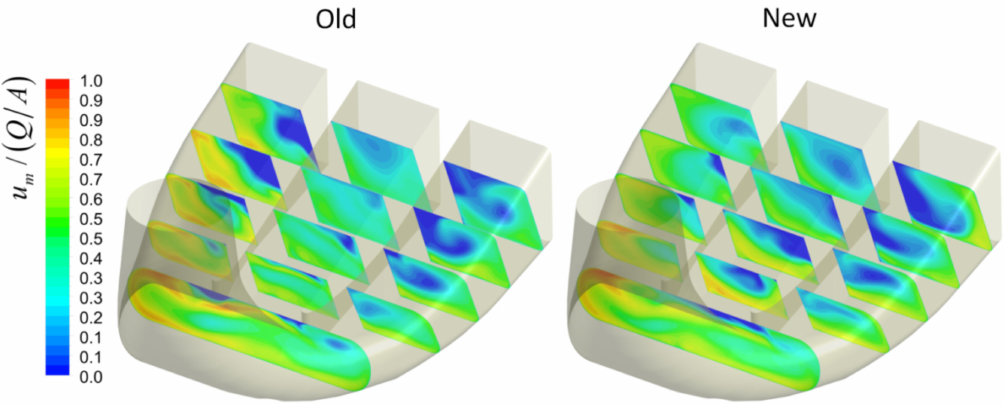
Figure 21. Flow velocity in the draft tube of old and new geometries of case 1 functions of the inlet area of the draft tube and the turbine discharge.